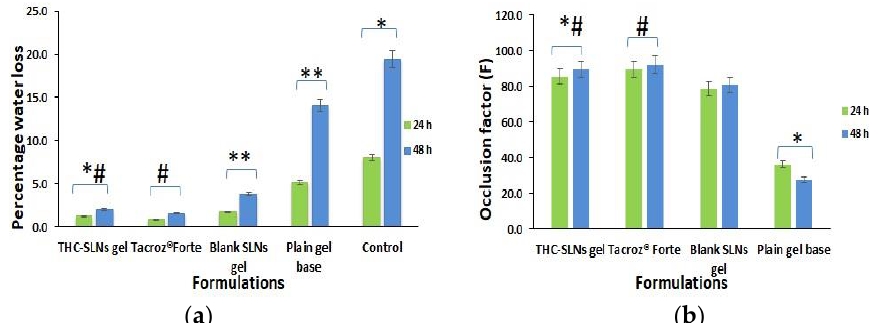
Figure 3. Graph depicting ( a ) percentage water loss with time and ( b ) occlusion factor, F, with time (each value represents mean ± SD ( n = 3)). One-way ANOVA followed by Tukey’s test: * denotes a significant difference at p ≤ 0.05 from control group; ** denotes a significant difference at p ≤ 0.05 from plain Carbopol gel; # denotes no significant difference at p ≤ 0.05.